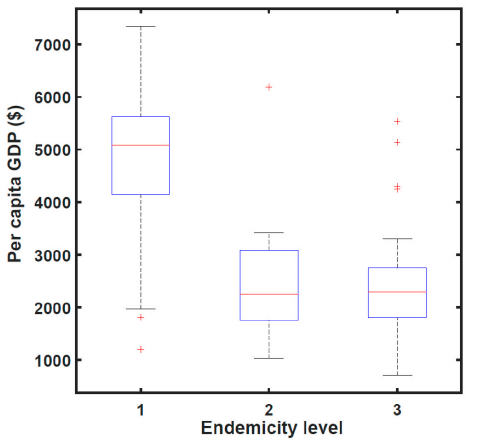
Figure 4. The relationship between endemic level and per capita GDP by county in 2008. The three levels of endemicity are, 1—transmission interruption (18 counties); 2—transmission control (18 counties); and 3—active transmission (26 counties). Overall, counties in level 1 had significantly higher per capita GDP (average $4291, p < 0.01) than that for level 2 counties ($2252) and level 3 counties